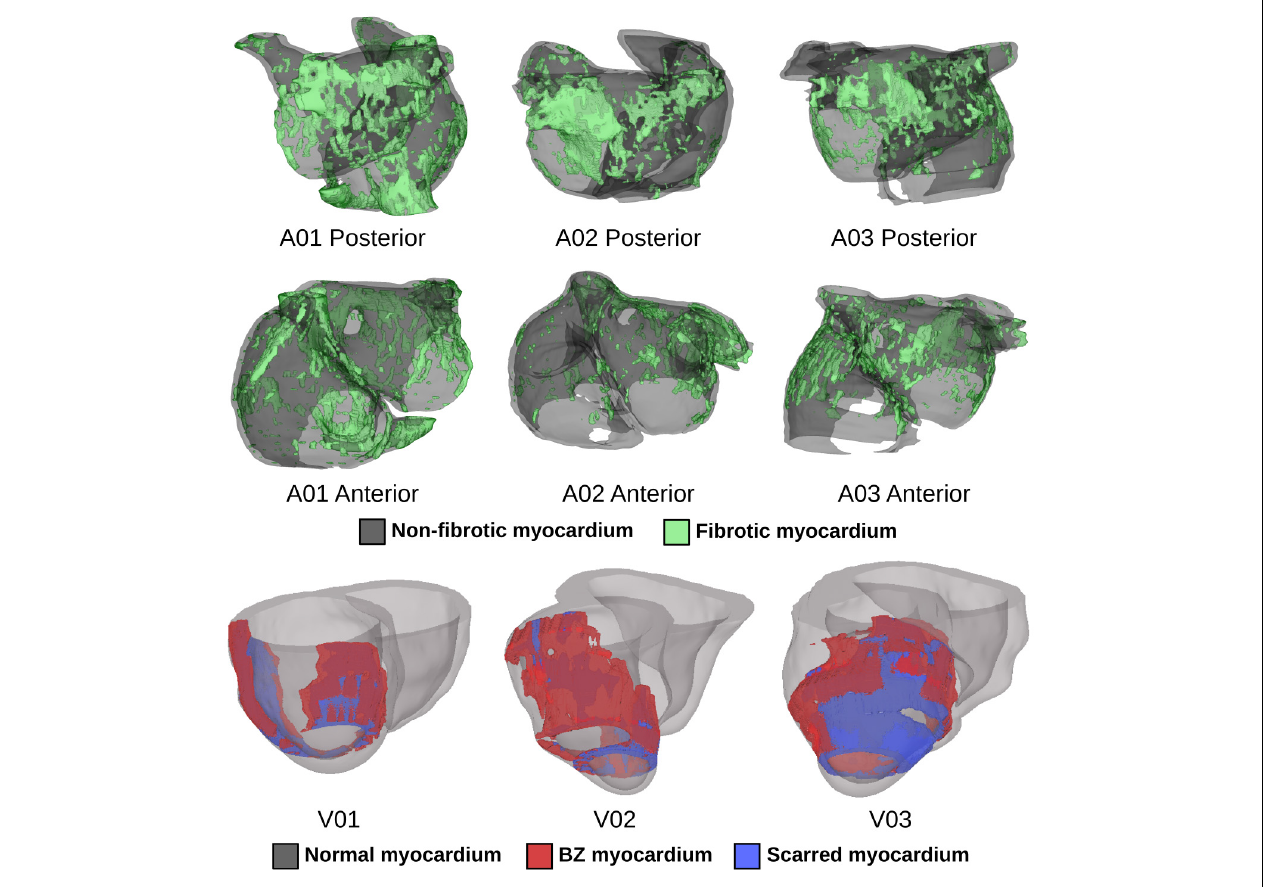
FIGURE 1 | Patient-specific atrial (top two rows) and ventricular (bottom row) models reconstructed from LGE-MRI scans. Spatial distribution of diseased tissue is shown for all